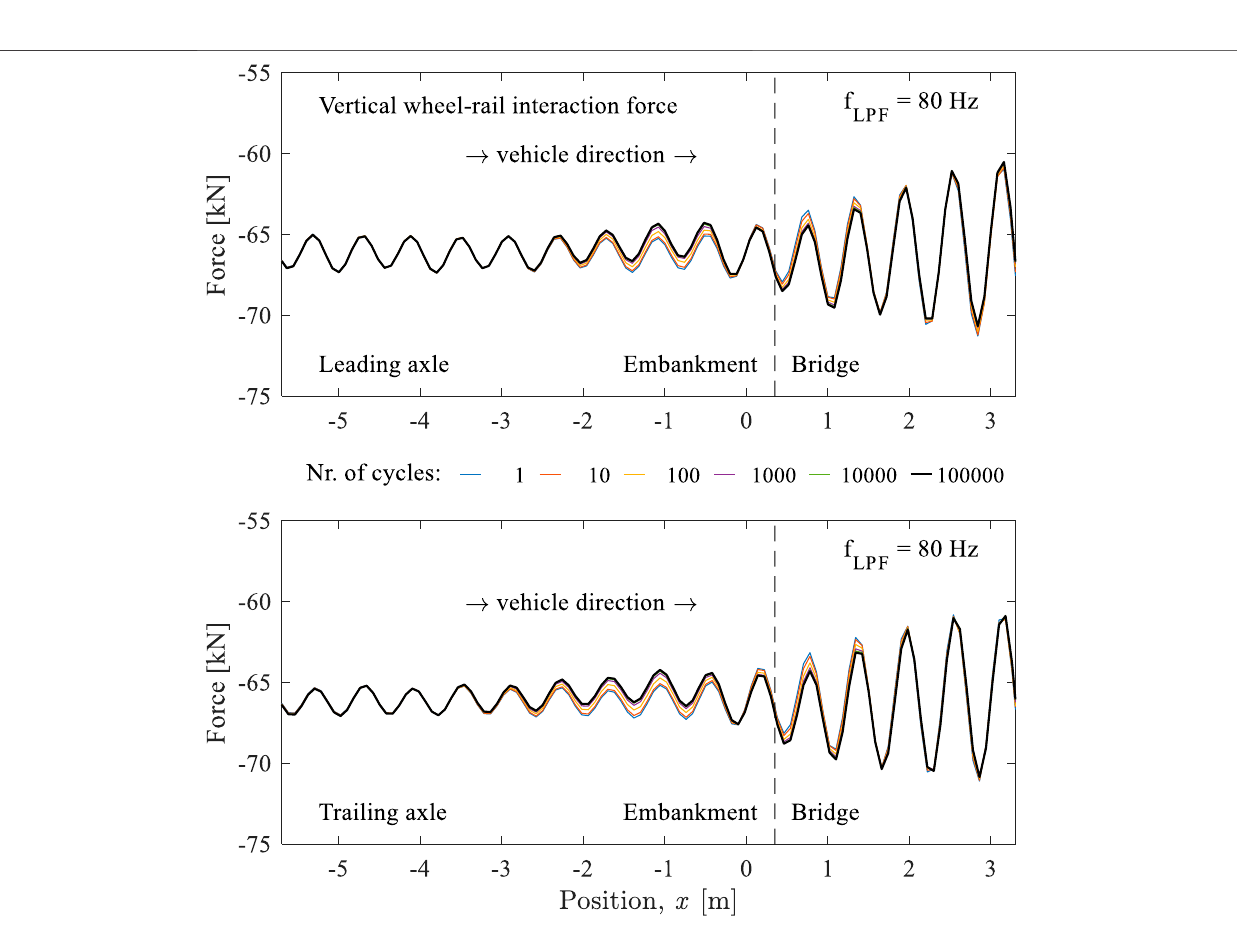
FIGURE 9 | Evolution of the wheel-rail interaction forces with N of the leading and trailing axles.